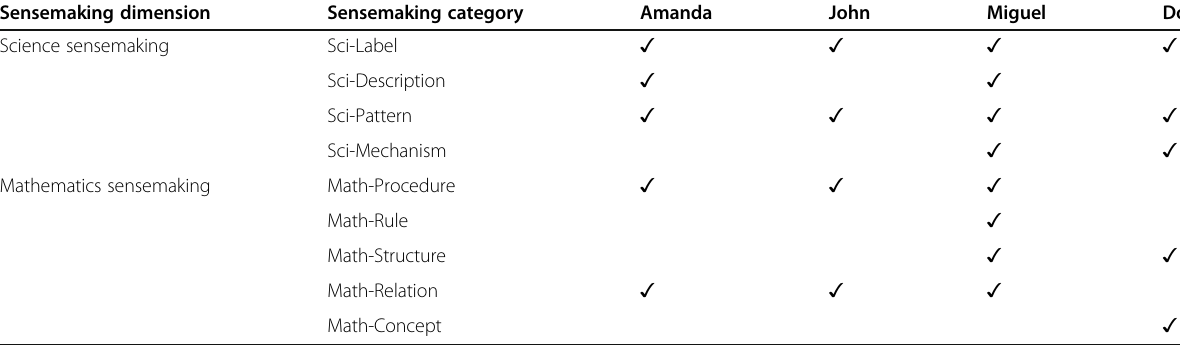
Table 5 Sensemaking opportunities during four instructors ’ lessons on equations in population growth Sensemaking dimension